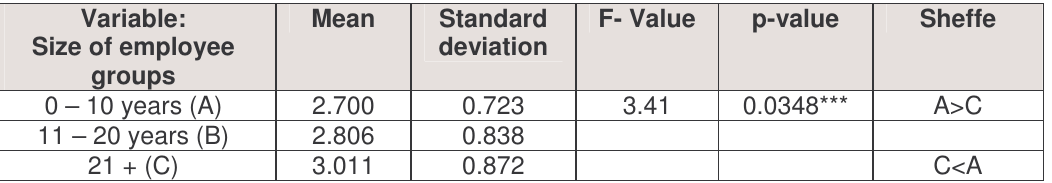
Table 7: ANOVA between different size of employee groups of entrepreneurs regarding support (partners and